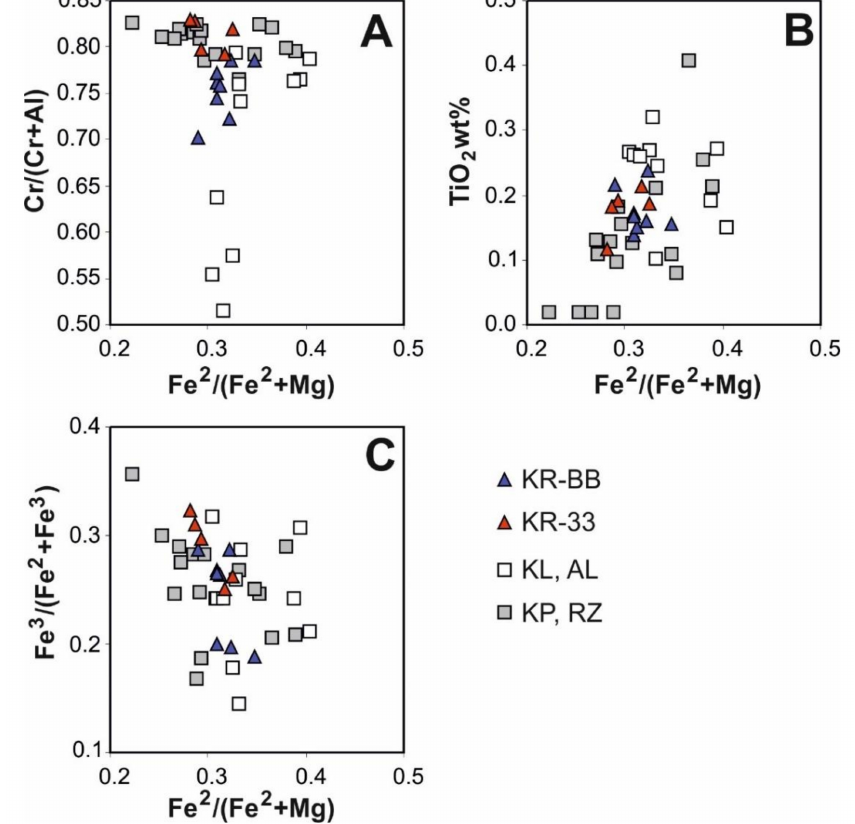
Figure 5. Compositional variations of chromite from Prospect 33 (KR-33) to Bolshoi Bashart (KR-BB) showing a decrease in chromium number Cr/(Cr + Al) = 0.83–0.79 to 0.79–0.70 ( A ); an increase in TiO 2 , 0.12–0.24 wt% ( B ); and an increase of the chromite oxidation state ( C ), with an increasing degree of differentiation expressed as Fe 2+ /(Fe 2+ + Mg). The compositions of chromite from other chromite deposits of the Urals are shown for comparison: Alapaevsk (AL), Kluchevskoy (KL), Kempirsai (KP), and Ray-Iz (RZ) (data from